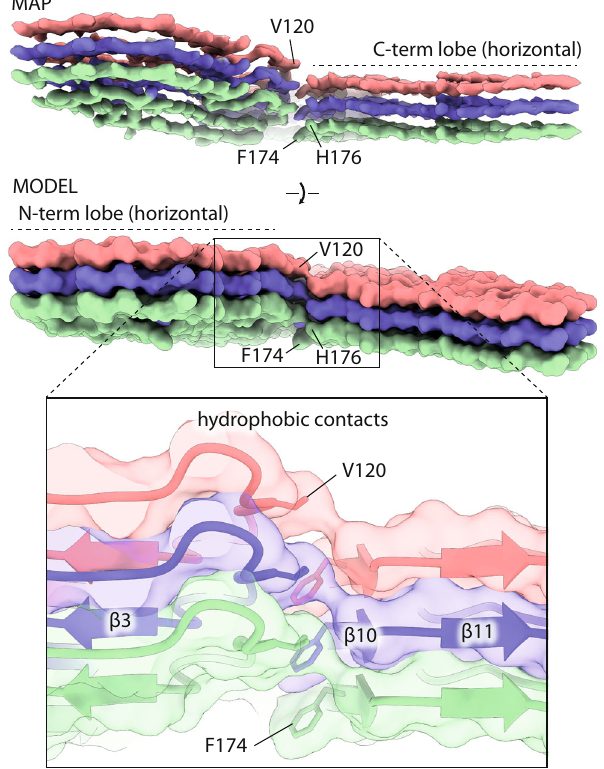
Fig. 3 Staggering of the N- and C-terminal lobes in the RML prion fi bril. Top, cryo-EM density (MAP) and solvent-excluded surface (MODEL) of three rungs, with indicated side chains that connect to form the inter-lobe contacts. The F174 and H176 residues are better visible in the MAP and MODEL views, respectively. Bottom, magni fi ed view of the staggered interactions (hydrophobic contacts) shown with transparent surface, main chain as ribbon and selected interacting residues as